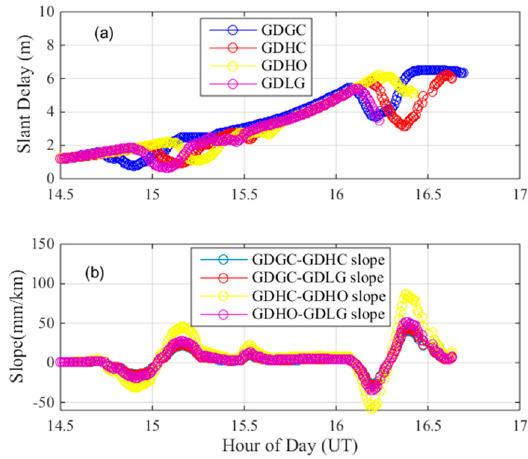
Figure 9. Ionospheric delay and gradient observed from the pairs of nearby stations on 24 March 2017. ( a ) dual-frequency estimates of slant ionospheric delay of nearby stations; ( b ) ionospheric gradient observed form the pairs of nearby stations.